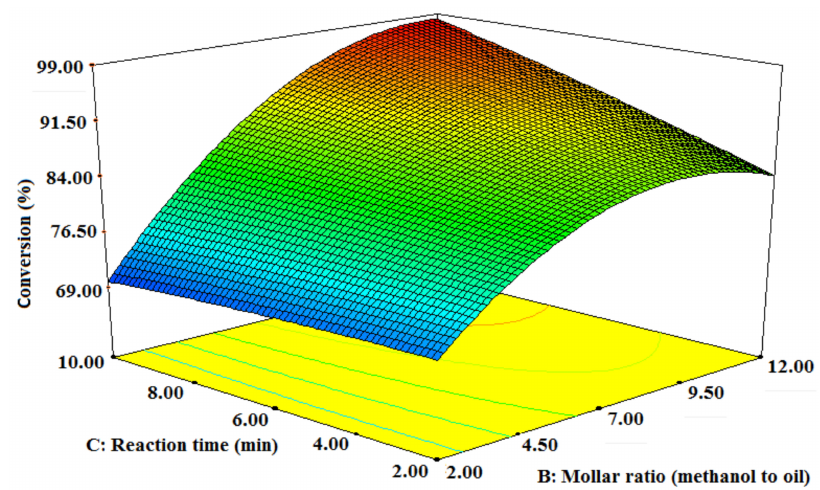
Figure 3. Effect of molar ratio (methanol to oil)—reaction time on biodiesel yield (%) when catalyst concentration (wt %) is equal to 1.5.